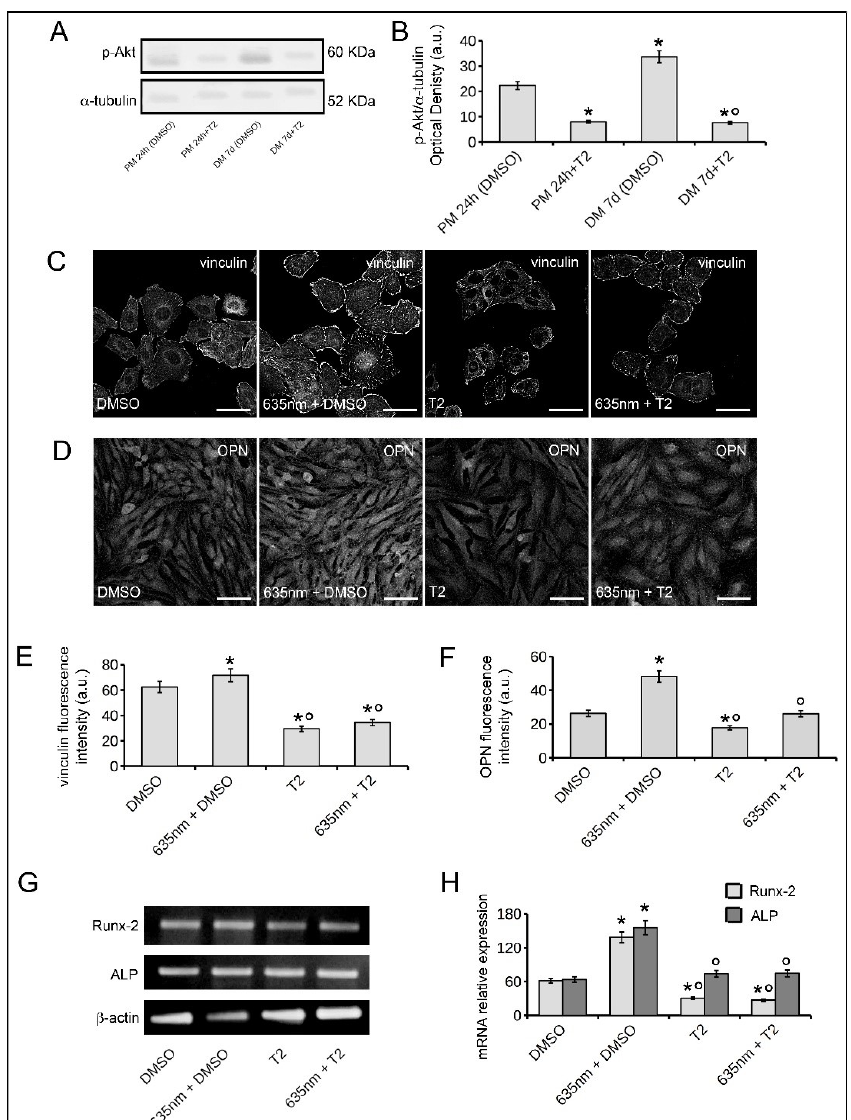
Figure 7. Assessment of Akt signaling involvement in osteoblast responses induced by red PBM. Osteoblasts subjected or not to PBM with 635 nm as reported in Table 1, were cultured for 24 h in PM or for 7 days (d) in osteogenic DM in the absence (DMSO) or presence of the Akt inhibitor, triciribine (2 µM, T2). ( A ) Western blotting analysis of p-Akt expression. ( B ) Histogram showing the densitometric analysis of the bands normalized to α-tubulin. ( C , D ) Representative confocal immunofluorescence images of cells cultured in the indicated experimental conditions. In ( C ) the cells were cultured in PM for 24 h, fixed immunostained with antibodies against vinculin; in ( D ) the cells were cultured in DM for 7 days, fixed and stained with antibodies against osteopontin OPN. Scale bar: 50 µm. ( E , F ) Histograms showing the densitometric analyses of the intensity of ( E ) vinculin and ( F ) OPN fluorescence signals performed on digitized images. ( G ) RT-PCR analyses of Runx-2 and ALP expression in the cells cultured for 7 days in DM in the indicated experimental conditions. Representative agarose gels are shown. ( H ) Histograms showing the densitometric analyses of Runx-2 and ALP bands normalized to β-actin. The data are representative of at least three independent experiments, performed in triplicate. The values are expressed as mean ± S.E.M. Significance of difference: in ( B ), * p < 0.05 vs. PM 24 h (DMSO), ° p < 0.05 vs. DM 7 days (DMSO); in ( E , F , H ), * p < 0.05 vs. DMSO, ° p < 0.05 vs. 635 nm + DMSO.